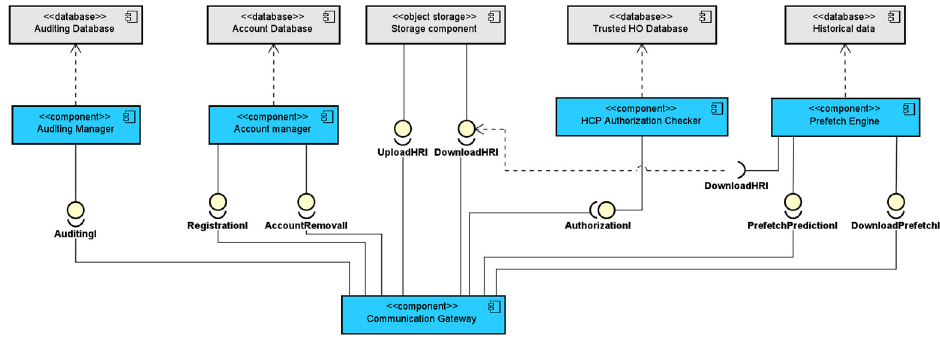
Figure 1. High-level view of the proposed cloud storage solution integrated with the novel prefetch engine mechanism.